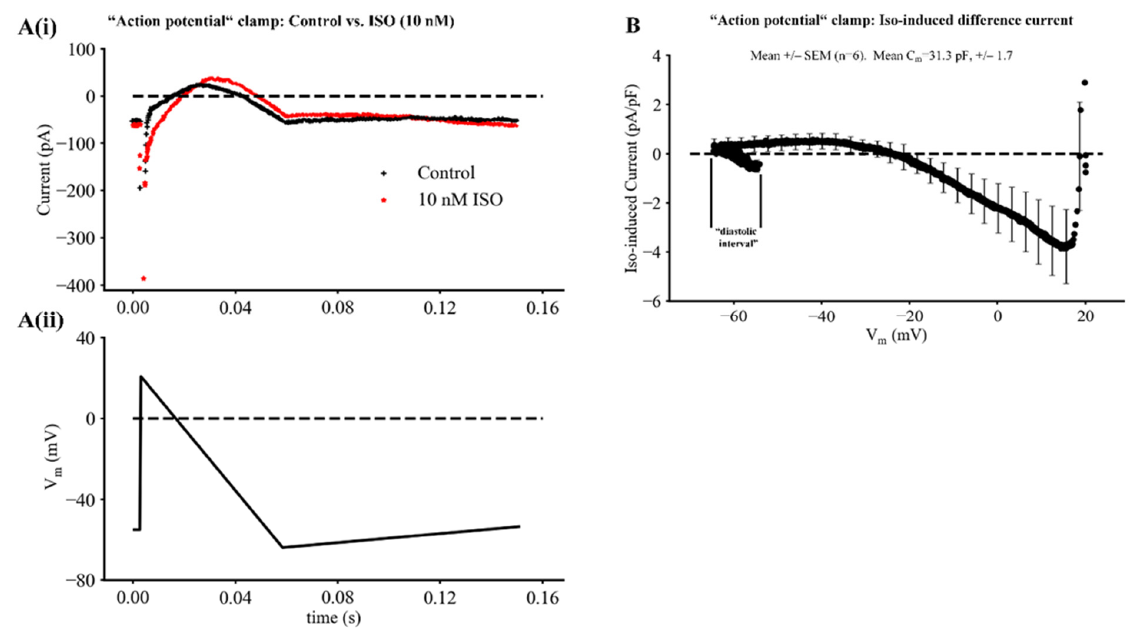
Figure 9. Ramp voltage clamp procedure to reveal the ISO-induced current changes during the action potential and pacemaker depolarization in adult mouse SAN. ( A ) Superimposed current records, each obtained after averaging 6 current traces generated by repetitive application of the action potential-like voltage ramp waveforms shown in Panel Aii. The baseline or control record is in black and the analogous averaged record obtained after 10 nM ISO application is in red. ( B ) Mean I-V relation for the ISO-induced current obtained as an averaged record from six different SAN myocyte recordings. Note: (i) the large increase in net inward current in the voltage range approximately +20 to − 20 mV likely due to ISO-induced augmentation of I Ca-L ;) and (ii) that ISO at 10 nM also resulted in a consistent but very small increase in net outward current at membrane potentials between − 20 and approximately − 65 mV (see Section